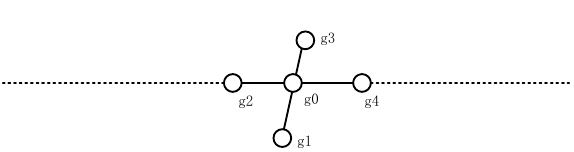
Figure 6. UAV patrol schematic.